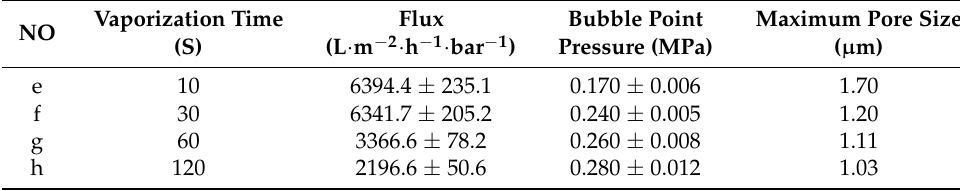
Table 7. The properties of membrane prepared under different evaporation